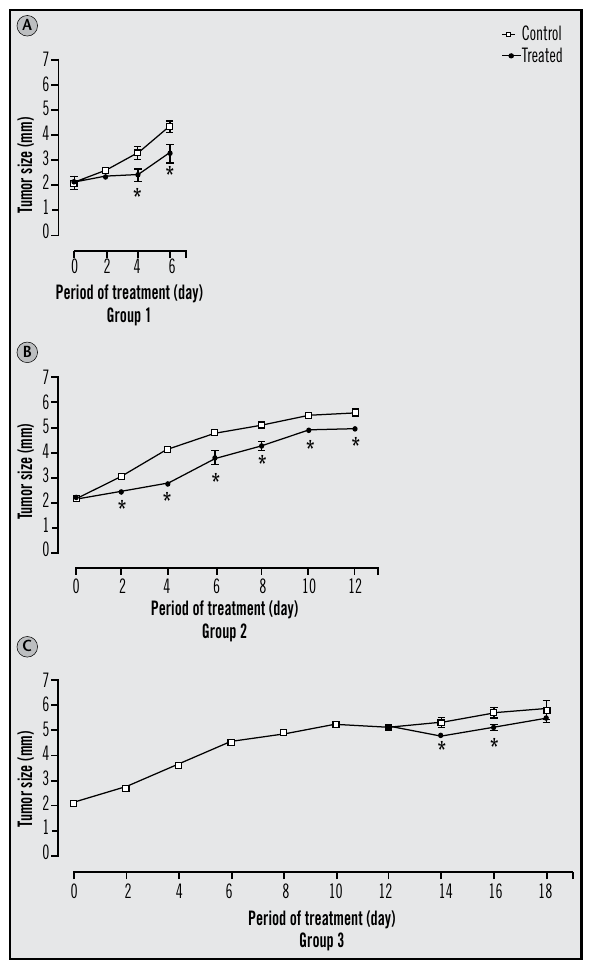
Figure 1 – Effect of systemic administration of Kint3-4 protein on Ehrlich tumor growth (A) Group 1 (0-6 days); (B) group 2 (0-12 days); (C) group 3 (0-18 days). Data represent mean ± SEM (* p < 0.05; t-test) significant difference between the values of control and treated groups.